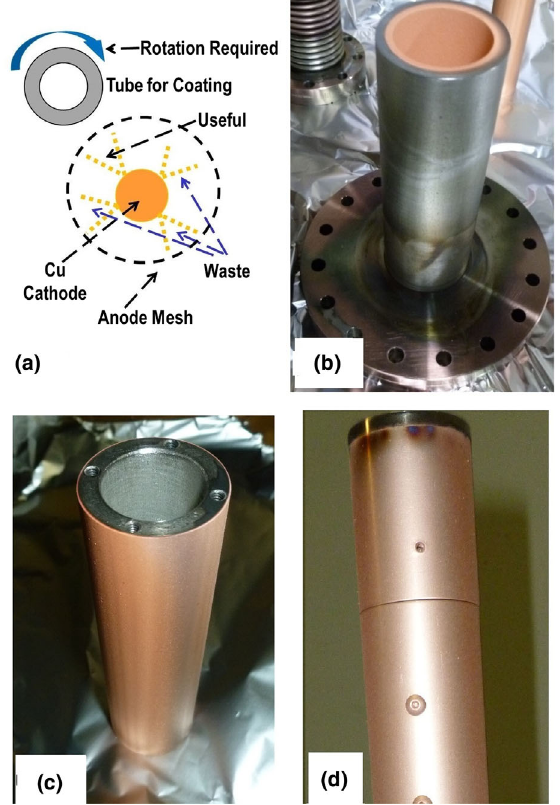
FIG. 7. (a) Arrangement for coating the outer surface of a tube with CED, (b) coating the inside surface of a tube with CED, (c) coating the outer surface of a tube with CED, and (d) coating of the outer surface of a tube with